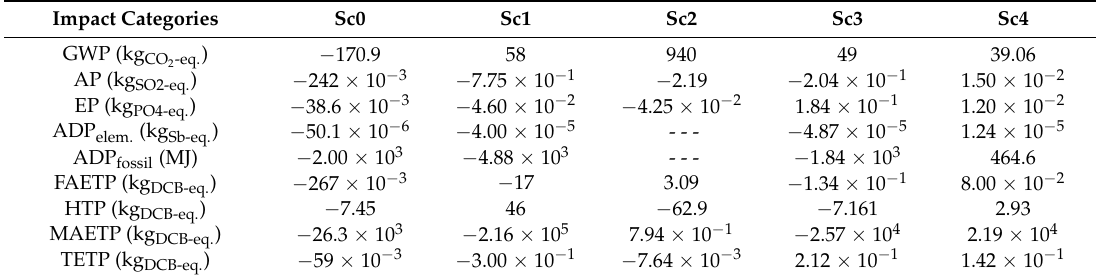
Table 6. Results for the evaluated scenarios in the sensitivity